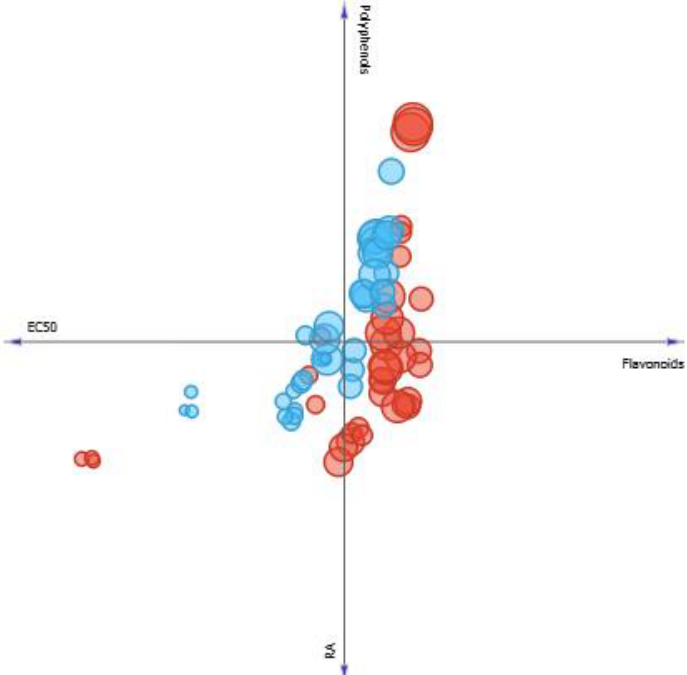
Figure 7. Four axes linear projection correlating the content of phenolics, flavonoids, rosmarinic acid, EC 50 of M. villosa (blue circles) and P. amboinicus (red circles). Circles size correspond to a greater or lesser SPF value found.